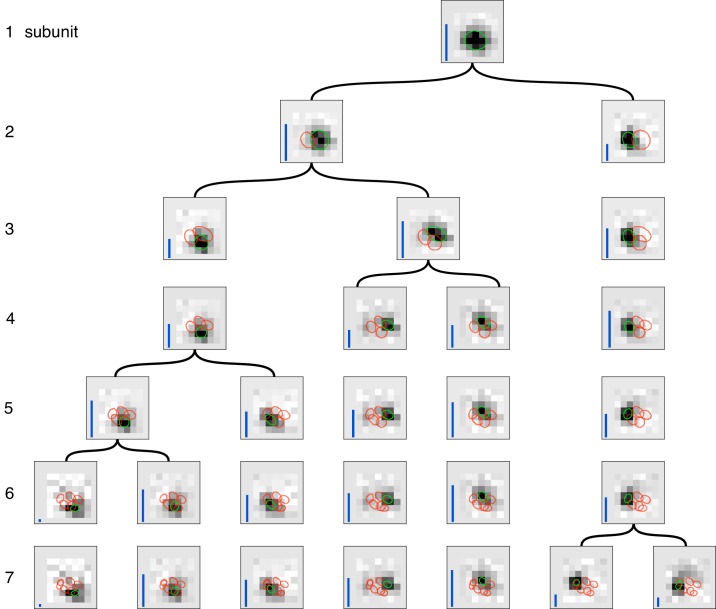
Gradual partitioning of the receptive field into subunits by hierarchical clustering.Different number of subunits (rows) estimated by splitting one parent subunit into two subunits at each step. Children subunits estimated by soft-clustering the simulated spikes of the parent subunit, with the simulated spikes for parent subunit computed as the spiking activity of the cell, weighed by its soft-max subunit activation (see Materials and methods). The parent subunit that gives maximum decrease in log-likelihood on training data is chosen for splitting. The choice of training data, preprocessing and figure details same as Figure 2. The achieved splitting of subunits is similar to the pattern of splitting in Figure 2 for small number of subunits (1–5 subunits), but differs for larger number of subunits (6, 7 subunits). This suggests that enforcing the hierarchical constraint could lead to a more efficient estimation procedure.